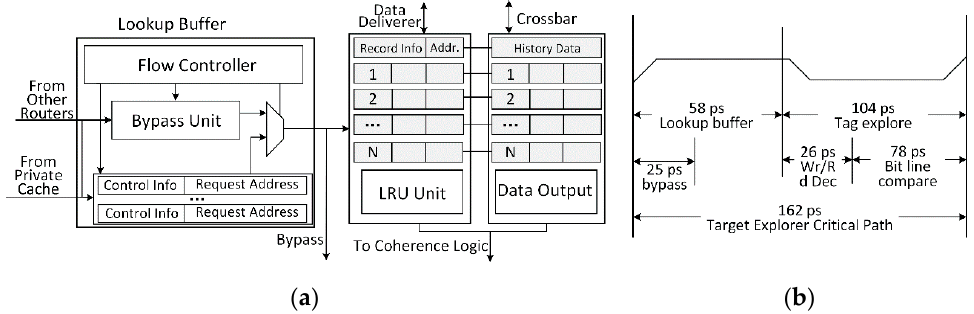
Figure 5. Architecture design on target explorer logic: ( a ) Hardware structure including lookup buffer and history tag and data buffers; ( b ) Critical path latency of target explorer when the history buffers contain 32 entries.